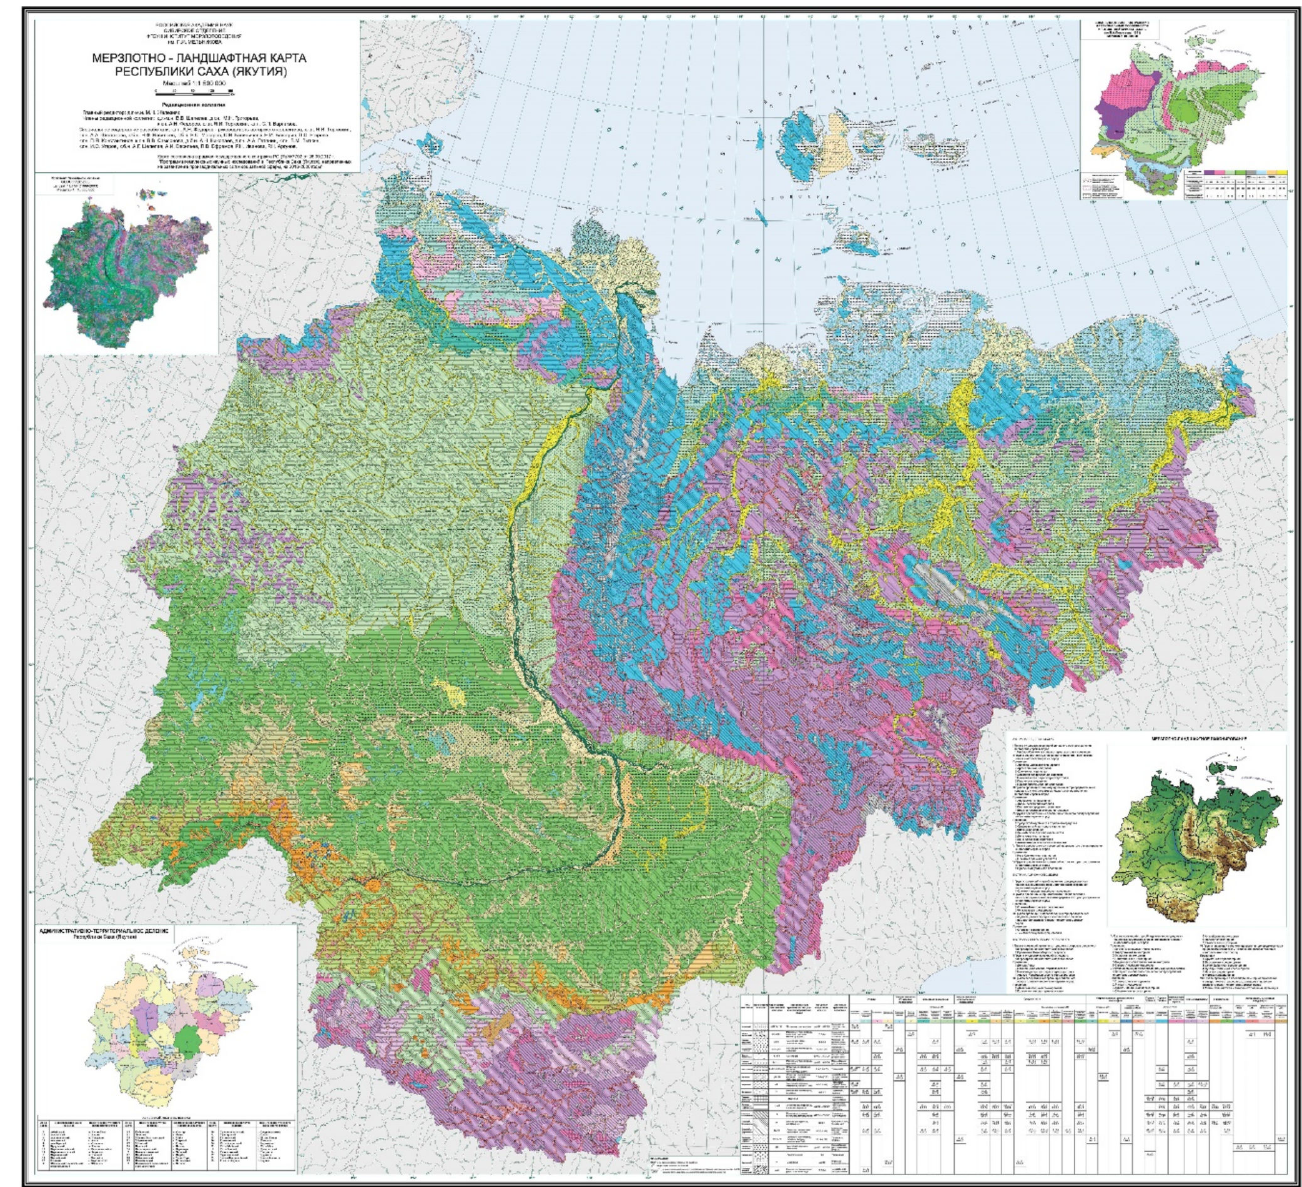
Figure 1. Permafrost landscape map of the Republic of Sakha (Yakutia) at a scale of 1:1,500,000 (http://mpi.ysn.ru/images/ mlk20182.pdf accessed on 1 December